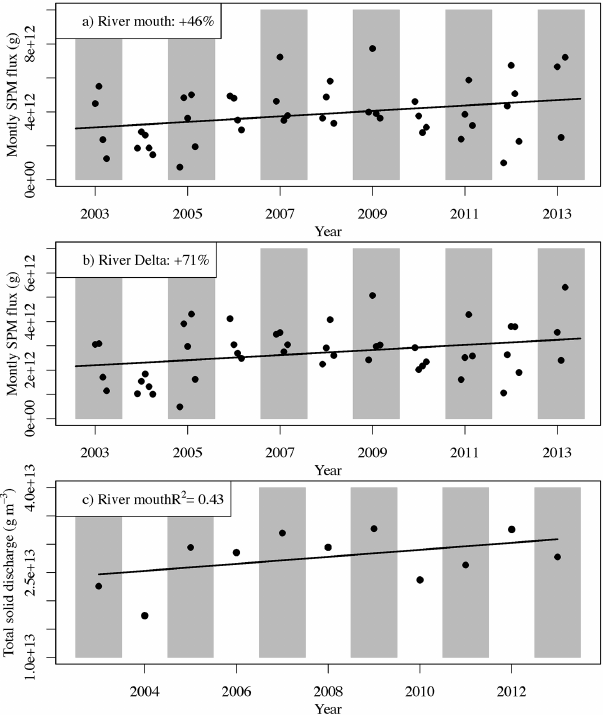
Figure 10. Monthly-averaged SPM flux (in g) estimated at the river mouth (geographical zone defined as a box with the boundaries 68.7–69.5 ◦ N and 133–137 ◦ W) in June, July, August and Septem- ber from 2003 to 2013 (a) . Same but for the delta zone (geographi- cal zone defined as a box with the boundaries 68.7–70 ◦ N and 132– 139 ◦ W) (b) . Total estimated mass (in g) of SPM delivered by the Mackenzie River into the Beaufort Sea during the summer period (June to September) from 2003 to 2013 (c) . Solid black lines corre- spond to the linear